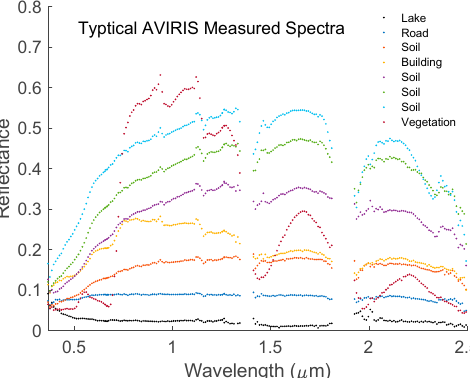
Figure 10. Typical measured reflectances by the AVIRIS instrument. The blank areas are wavelength ranges in which the reflectances cannot be measured accurately due to strong water absorption.